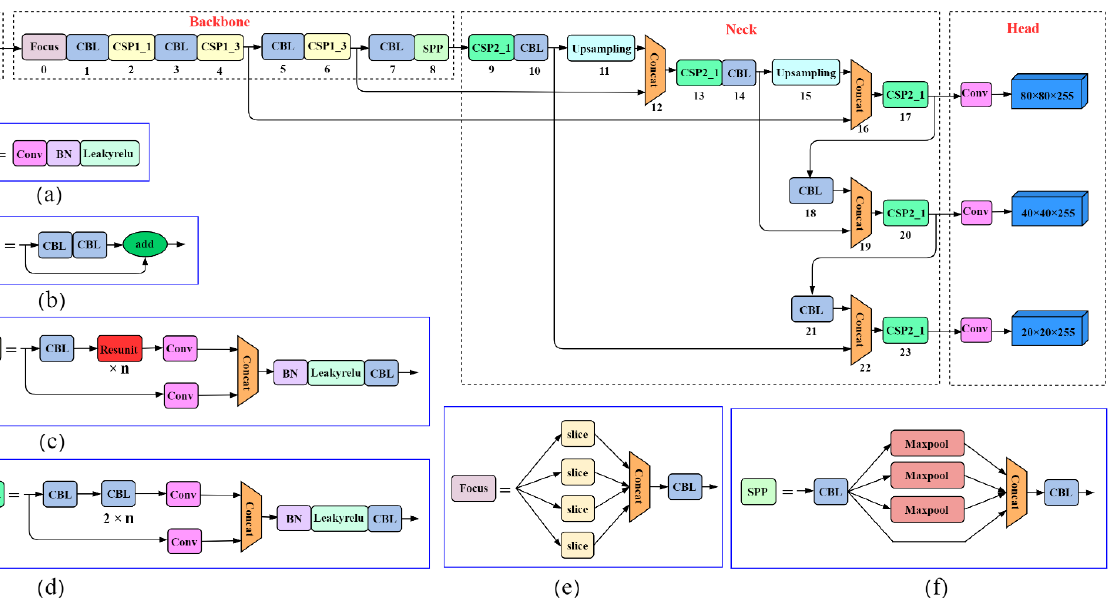
Figure 5. YOLOv5 network model: Image ( a ) is the CBL module, the CBL module consists of a Conv+BN+Leakyrelu activation function, Conv is convolution; image ( b ) Resunit borrowing from